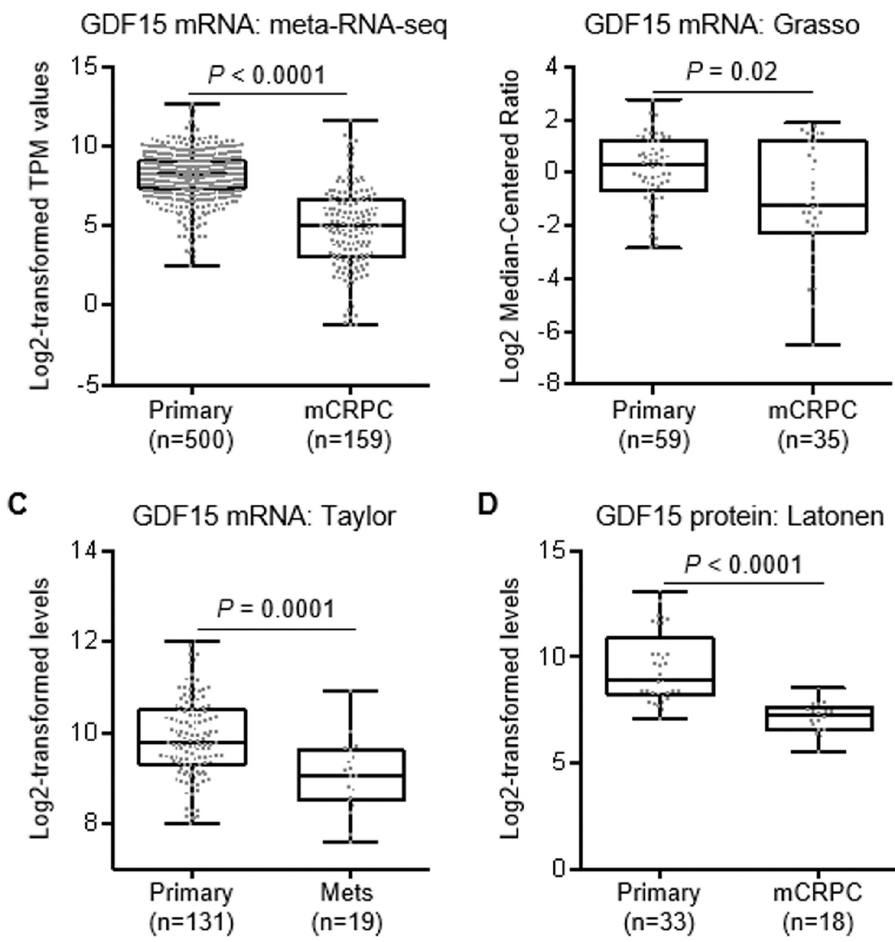
Fig 3. GDF15 RNA and protein levels are higher in primary human prostate cancer compared to metastatic samples. A , GDF15 RNA levels from RNA-seq data of 500 TCGA primary prostate cancer (primary) samples and 159 metastatic CRPC (mCRPC) samples from the SU2C, PROMOTE, and Beltran cohorts. B , GDF15 RNA levels from the Grasso microarray dataset (GSE35988) including 59 primary prostate cancer and 35 mCRPC samples. C , GDF15 RNA levels from the Taylor microarray dataset (GSE21034) including 131 primary and 19 metastatic prostate cancer samples. D , GDF15 protein levels from the Latonen proteomics dataset (PASS01126) including 33 primary prostate cancer and 18 mCRPC samples. TPM, transcripts per million. Numbers in parentheses, number of samples in each group. P values are from Mann-Whitney test.